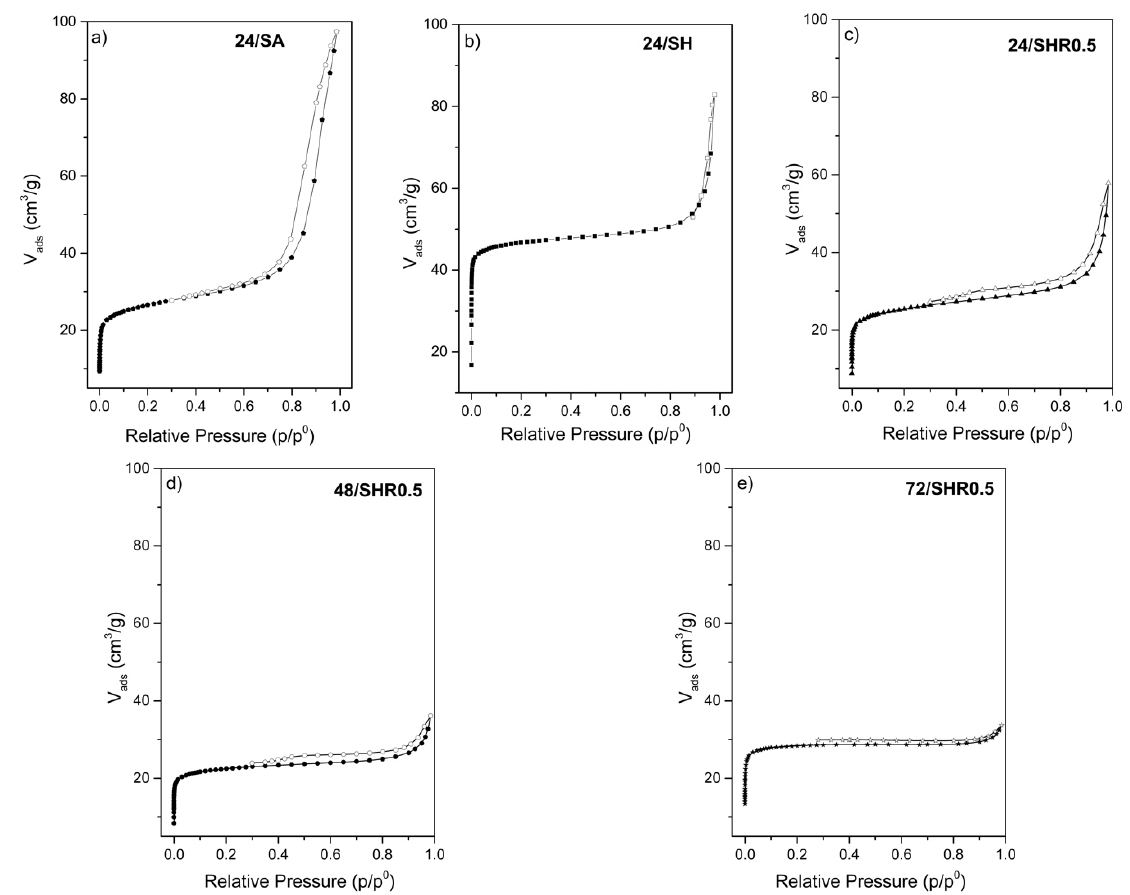
Figure 4. N 2 sorption isotherms for standard SAPO-11 obtained: ( a , b ) from the conventional method; ( c – e ) samples and using phosphor residues.